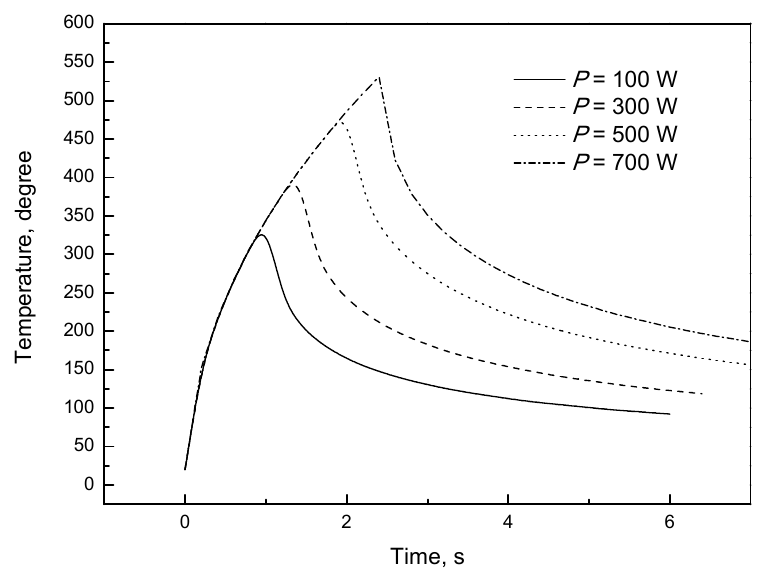
Figure 8. Variation of temperature with laser power.